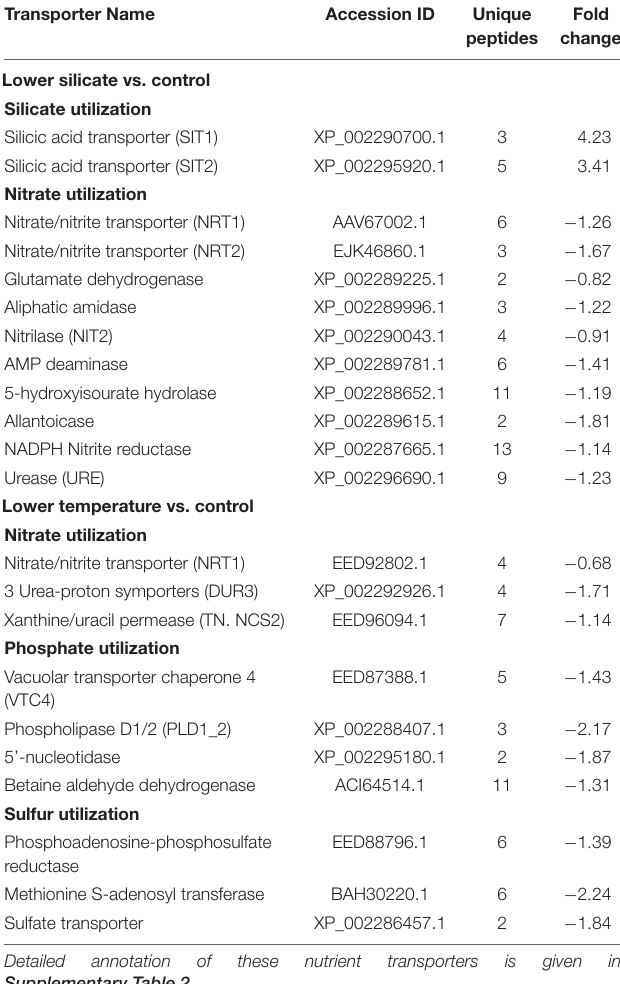
TABLE 1 | Differentially abundant proteins/transporters associated with the utilization of silicon, nitrate, phosphate, and sulfate in S. dohrnii treated with lower silicate and